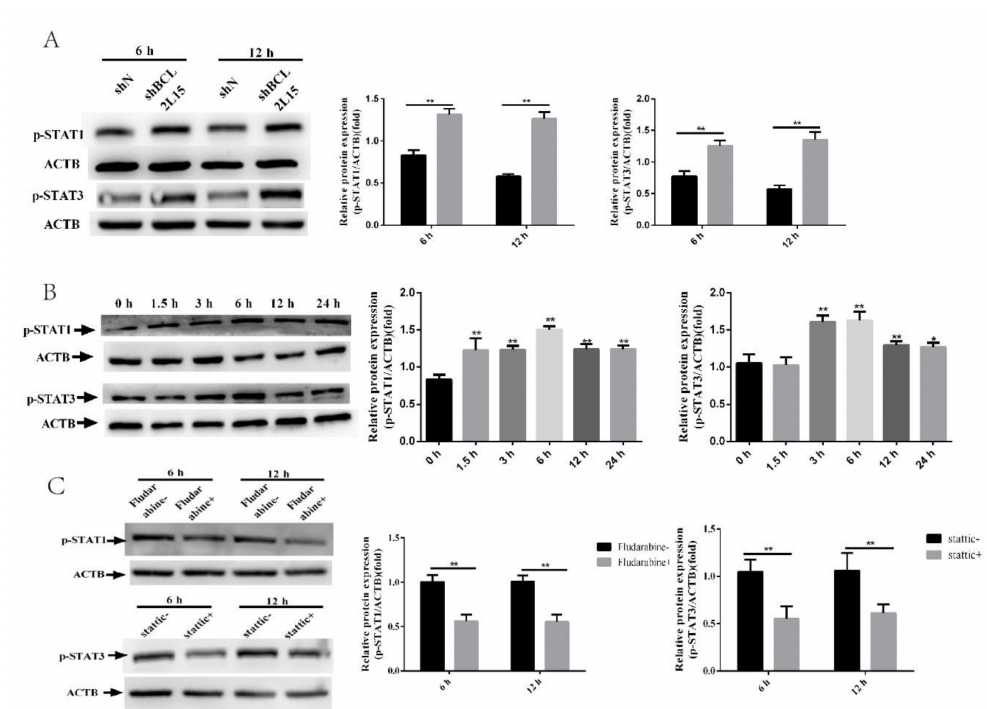
Figure 3. BCL2L15 a ff ected the signal transducer and activator of transcription (STAT)1 and STAT3 pathways. ( A ) The lentivirus specific for BCL2L15 and a negative lentivirus (shN) infected EECs for 48 h. EECs were treated with or without hormones followed by treatment with or without IFN- τ